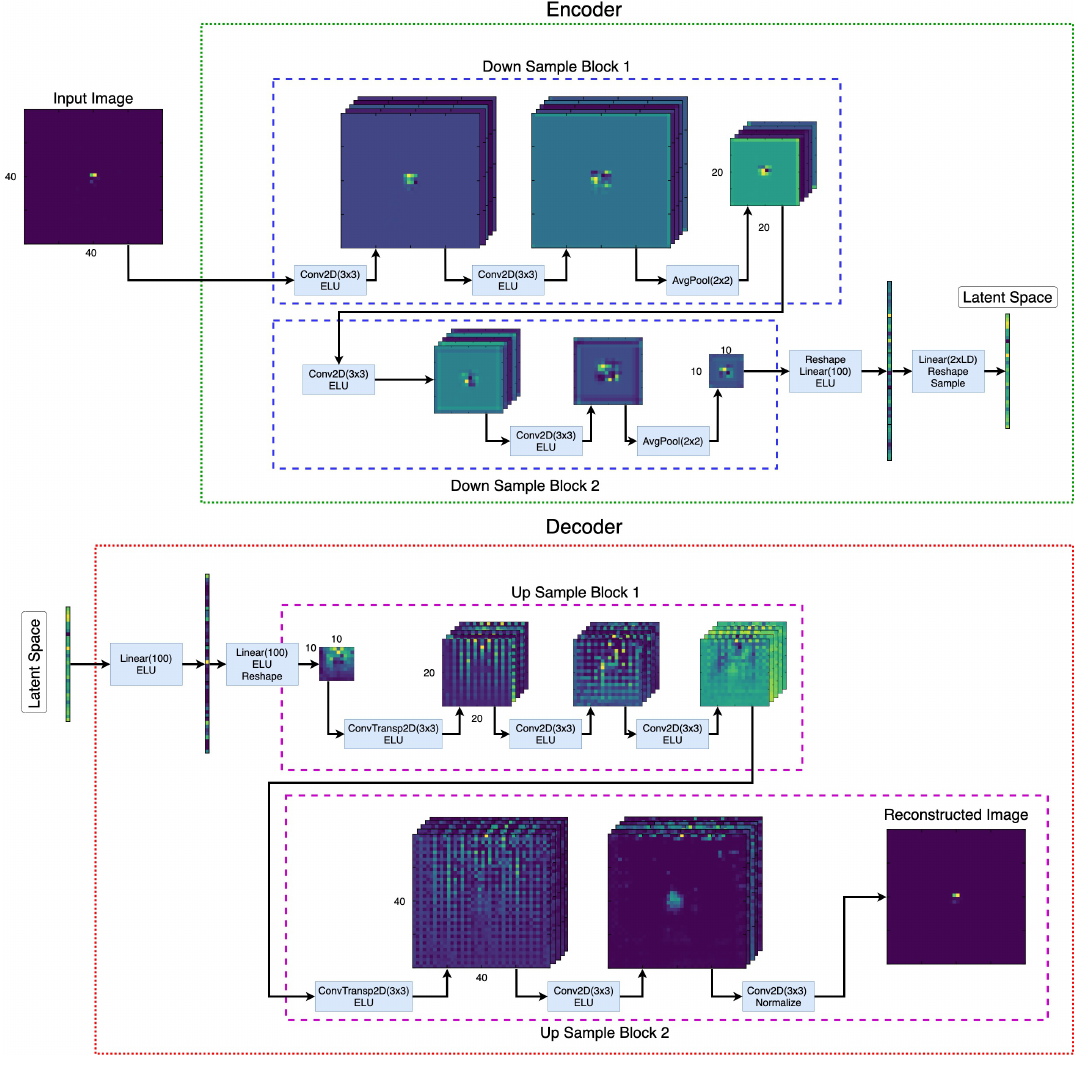
Figure 2 . Example architecture of an autoencoder, as used for this study. The autoencoder is made of two networks, the encoder and the decoder, each with one, two, or three down(up)-sampling